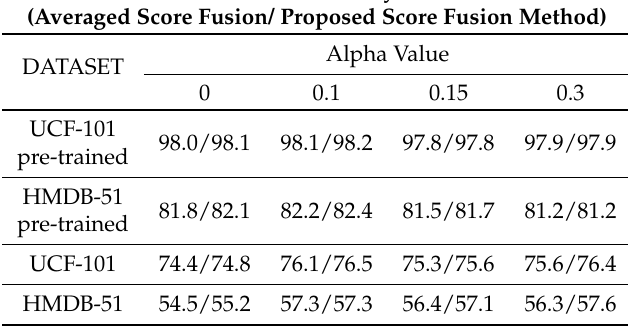
Table 5. Ablation